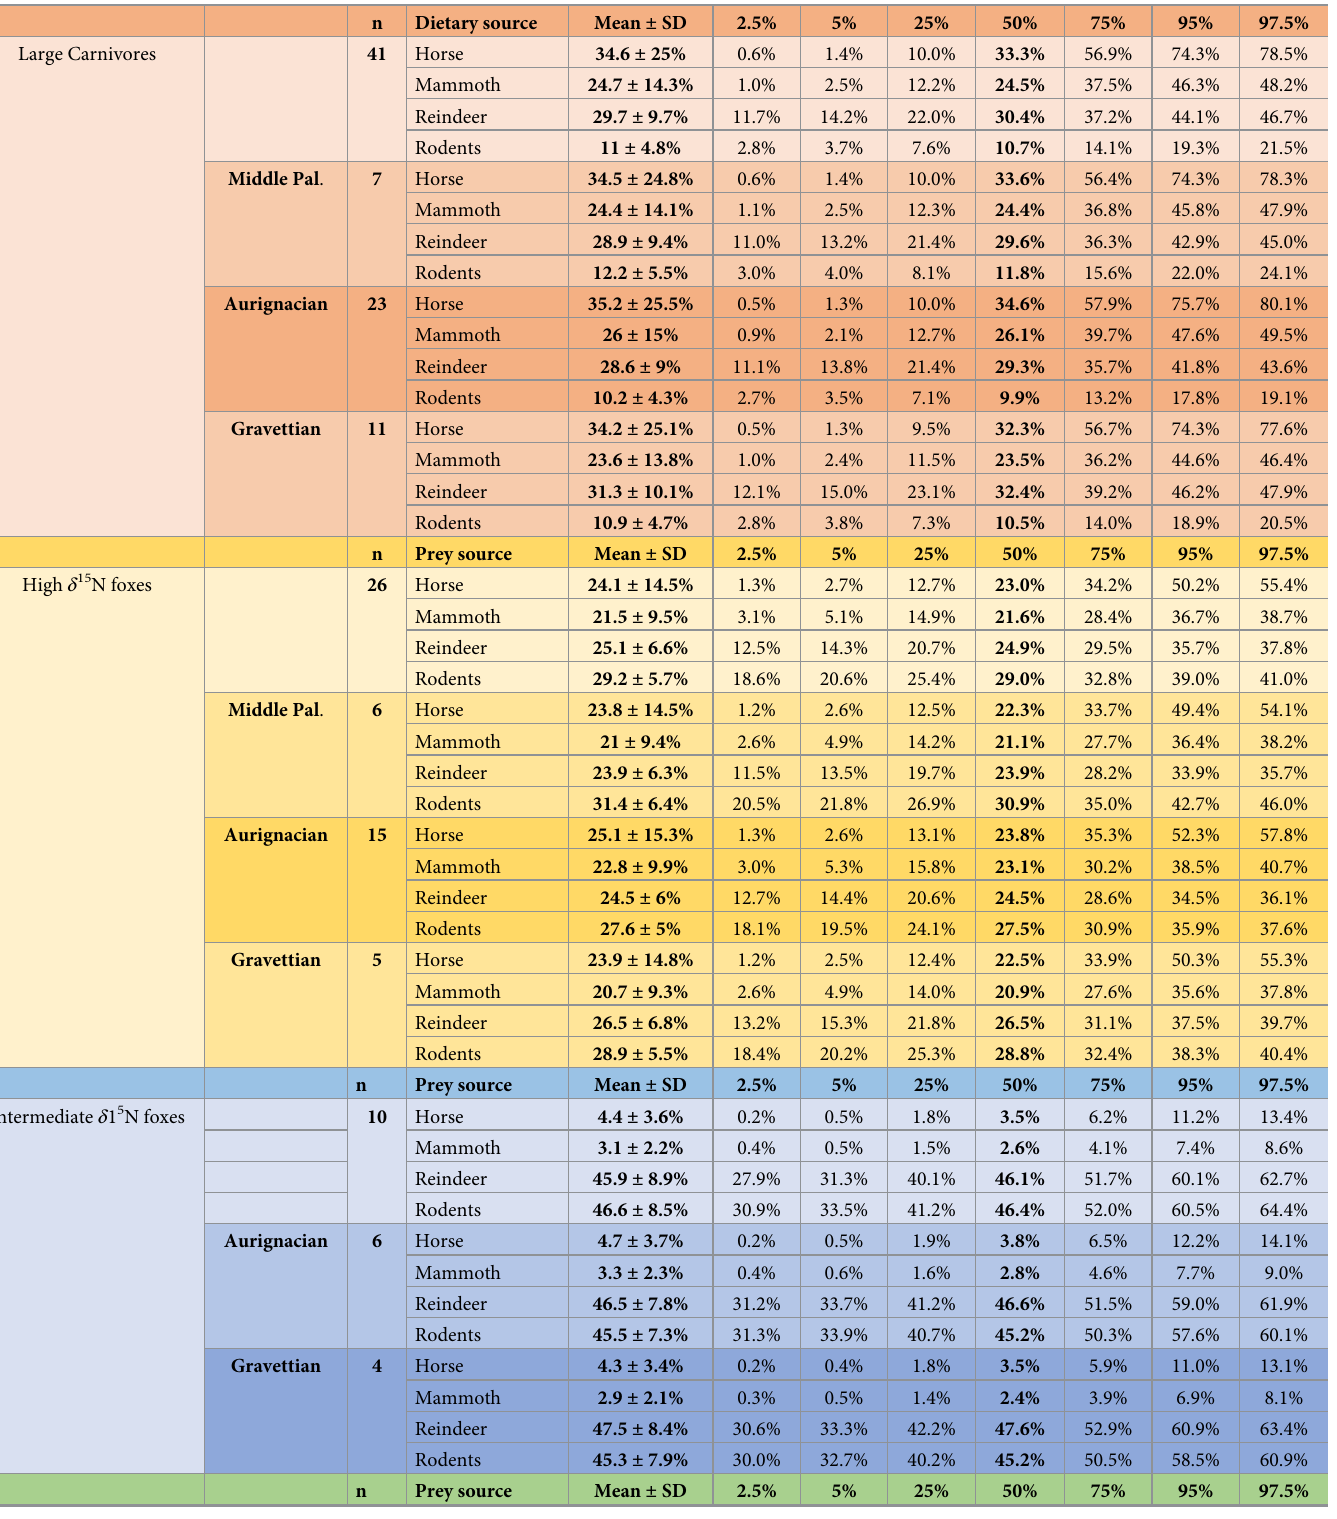
Table 4. Reconstructed dietary proportions for the different fox niches and large carnivore